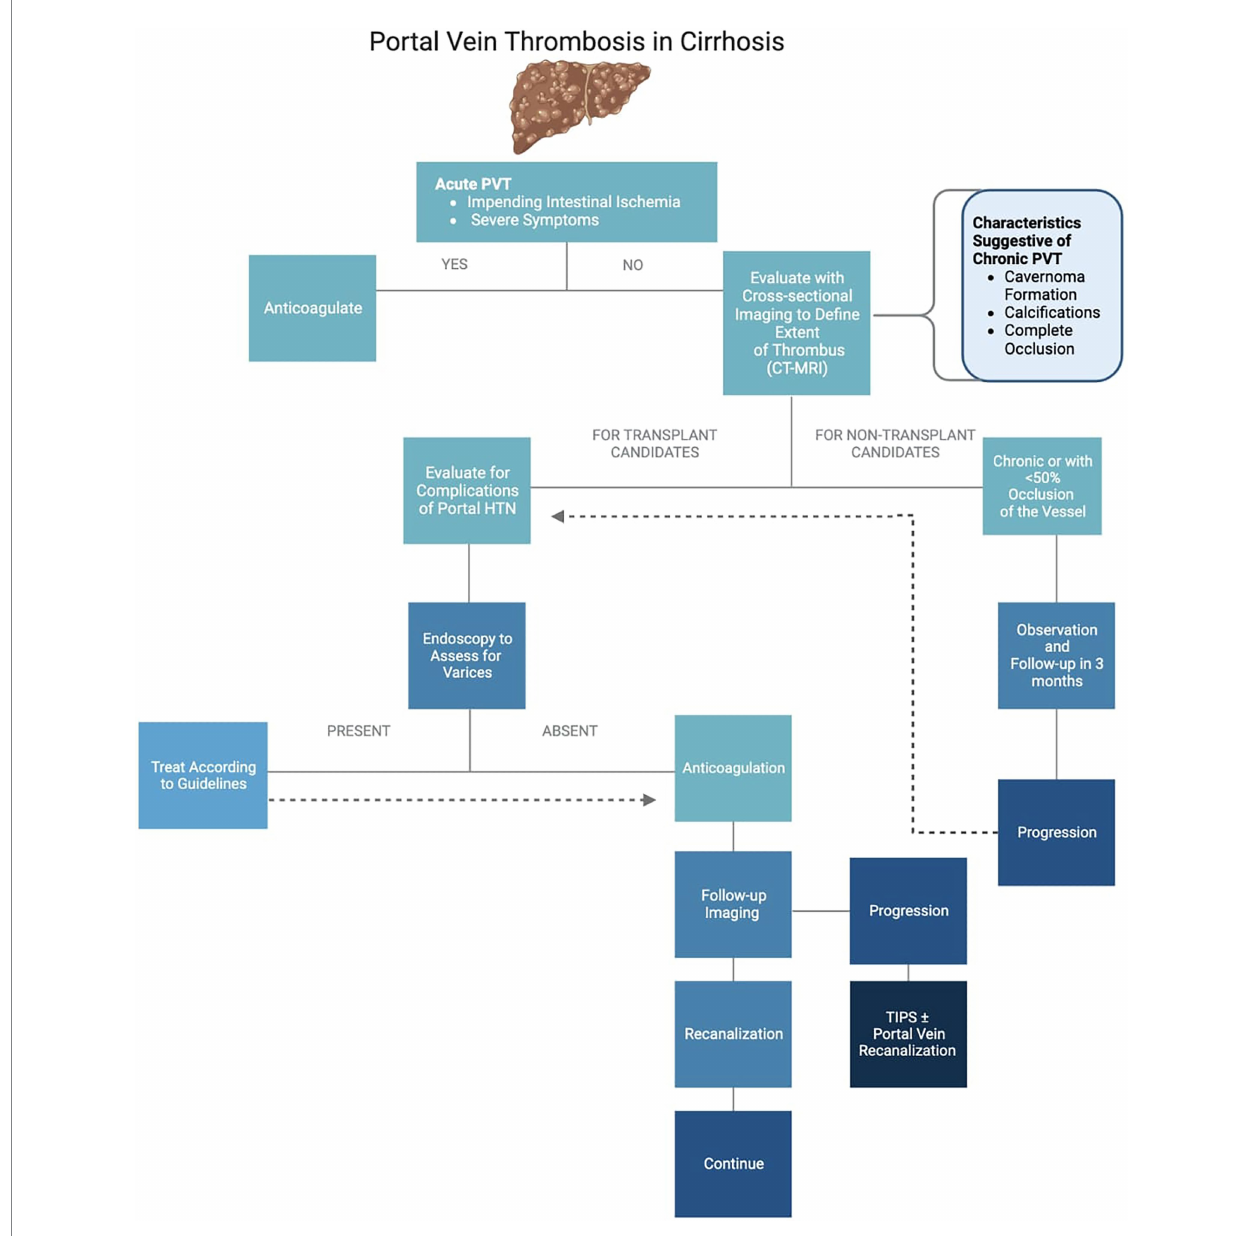
FIGURE 1 Treatment algorithm of portal vein